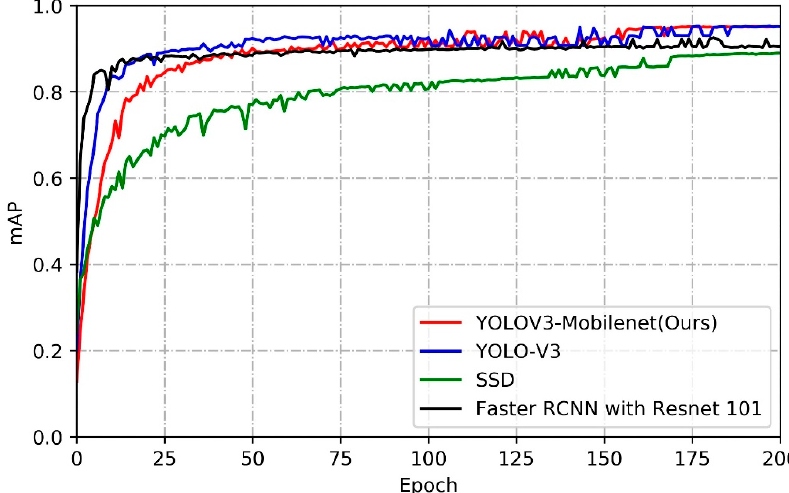
Figure 12. Mean average precision (mAP) value as a function of gradually increasing epoch.